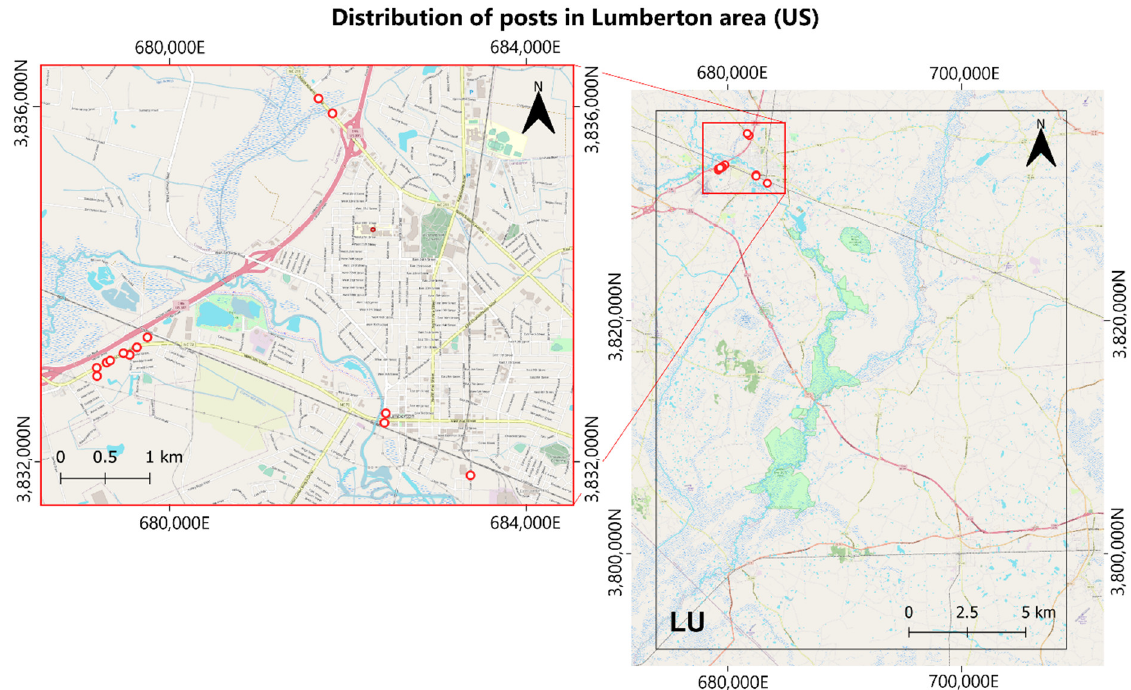
Figure 4. Distribution of posts used to build floodwater training samples for the Lumberton area (US). CRS: WGS84/UTM zone 17 N. Basemap data: OpenStreetMap contributors.